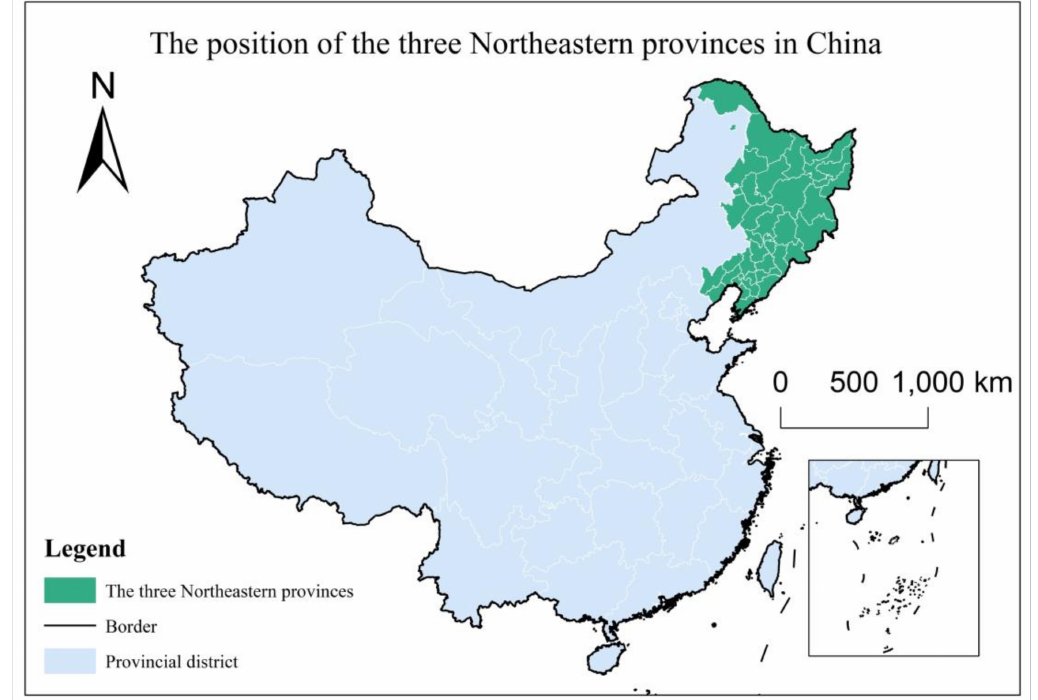
Figure 2. The position of three northeastern provinces in China.